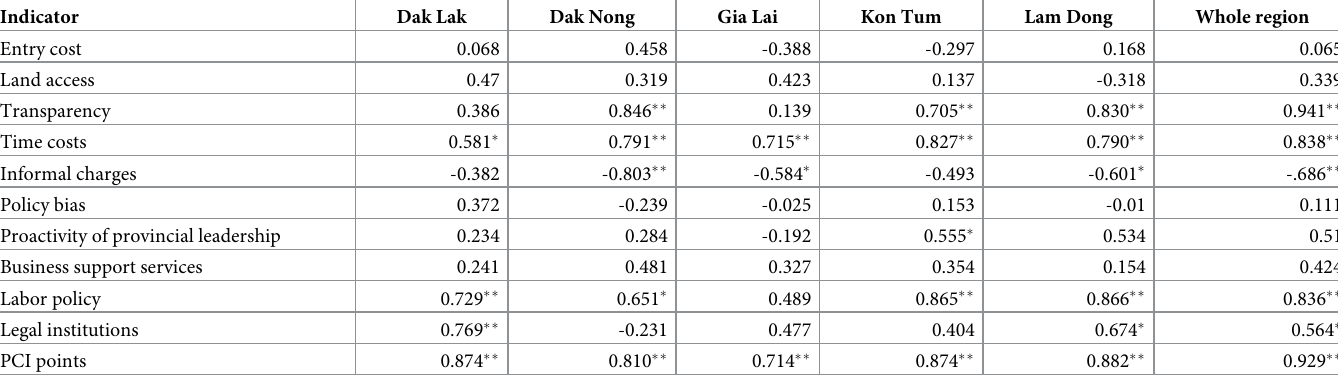
Table 5. Correlation between PCI and the number of enterprises in the Central Highlands in the 2006–2018 period.